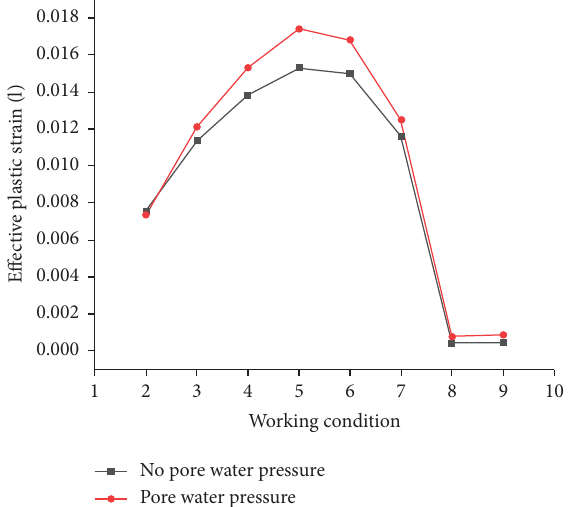
Figure 19: Maximum equivalent soil strain with and without pore water pressure